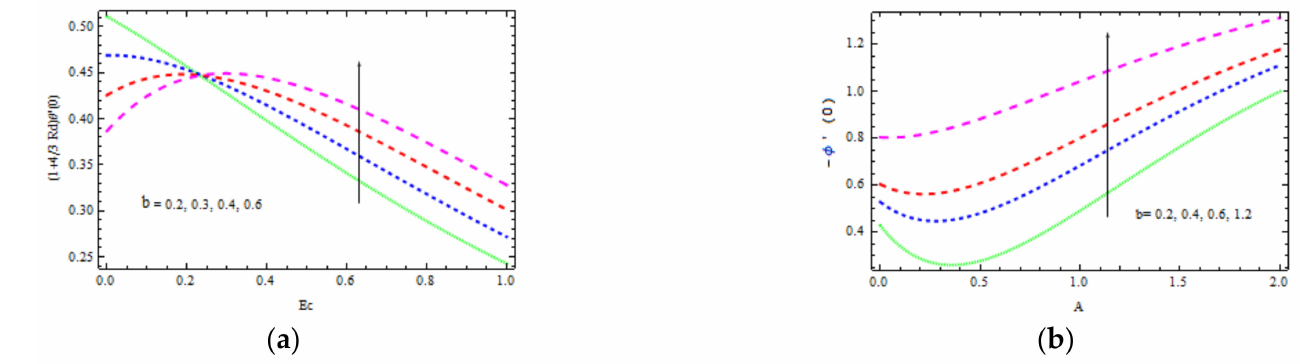
Figure 13. Inspiration of b, Ec ( a ) on Nusselt number and b, A ( b ) on Sherwood